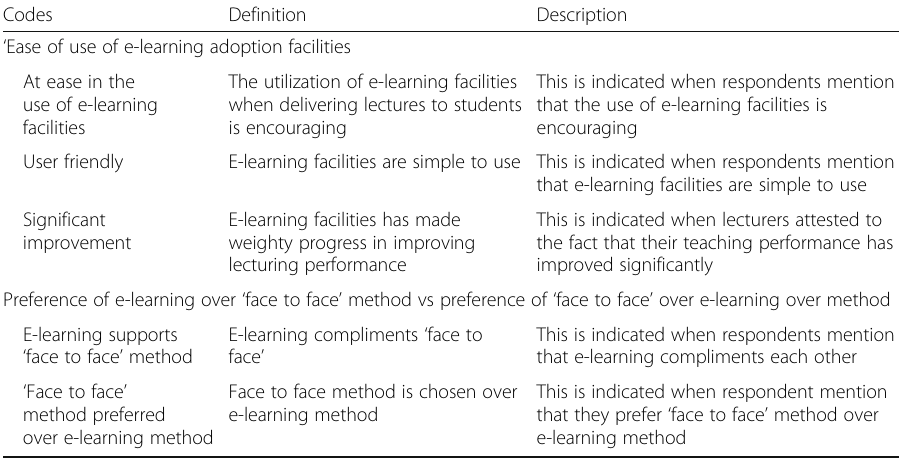
Table 3 Preference and ease of e-learning adoption over ‘ face to face ’ method Codes